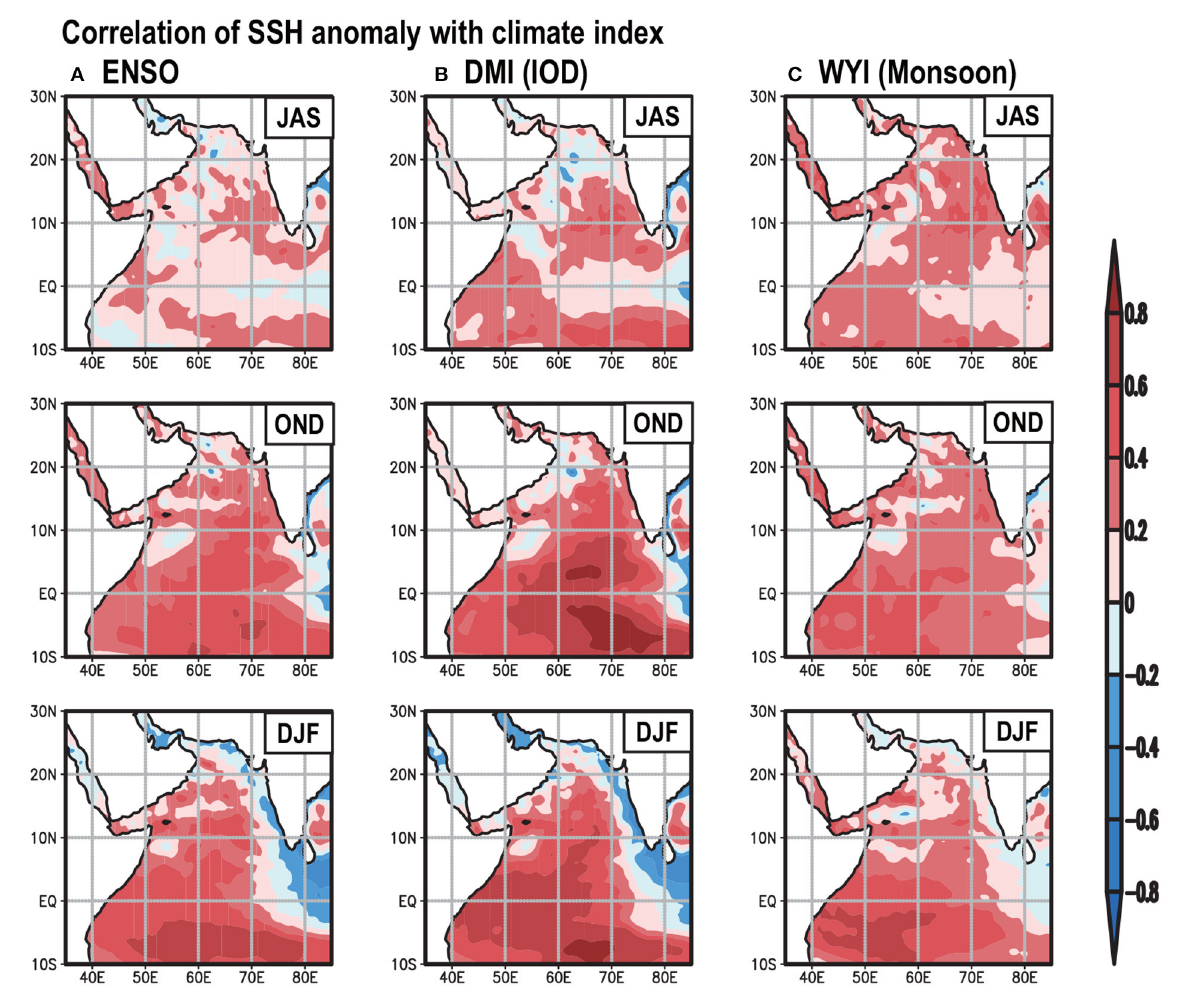
FIGURE5 (A) Correlation maps of AVISO-derived SSH anomalies with ENSO index in July–September (upper panel), October–December (middle panel), and December–February (bottom panel) during the period 1993–2016. (B,C) Are as in (A) , but show a correlation with the IOD index and monsoon index,